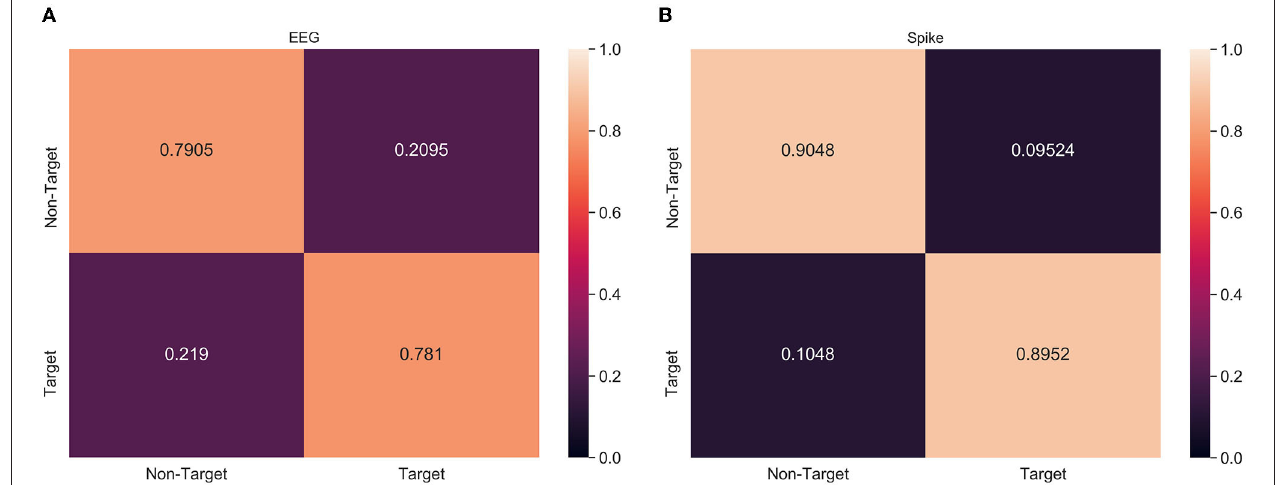
Frontiers in Neuroscience |